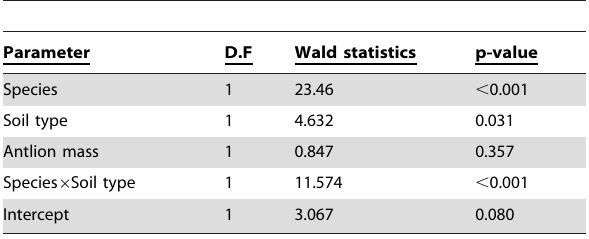
Table 1. Logistic regression analysis examining prey capture success in the foraging behavior experiment.